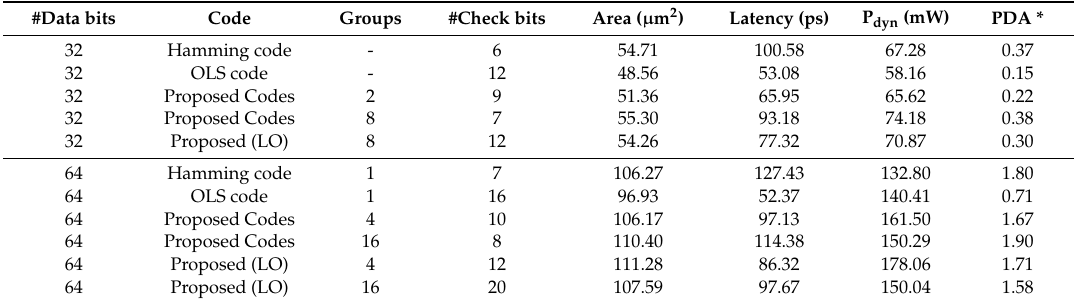
Table 2. Comparison of decoding circuit between the di ff erent